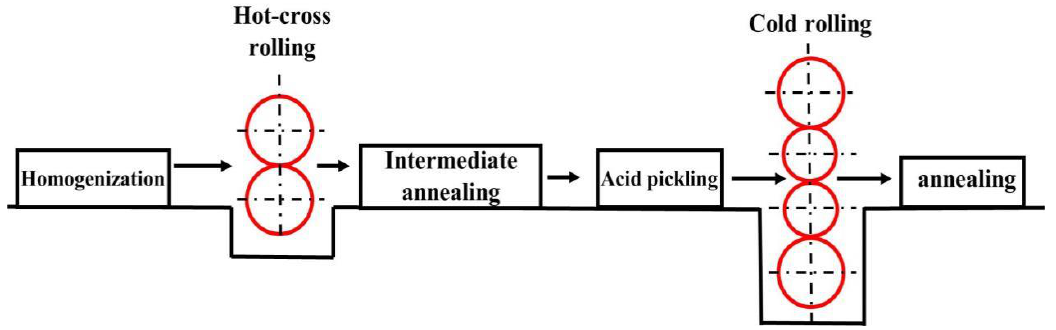
Figure 1. Schematic diagram of Cu-2.7Be sheets processing.